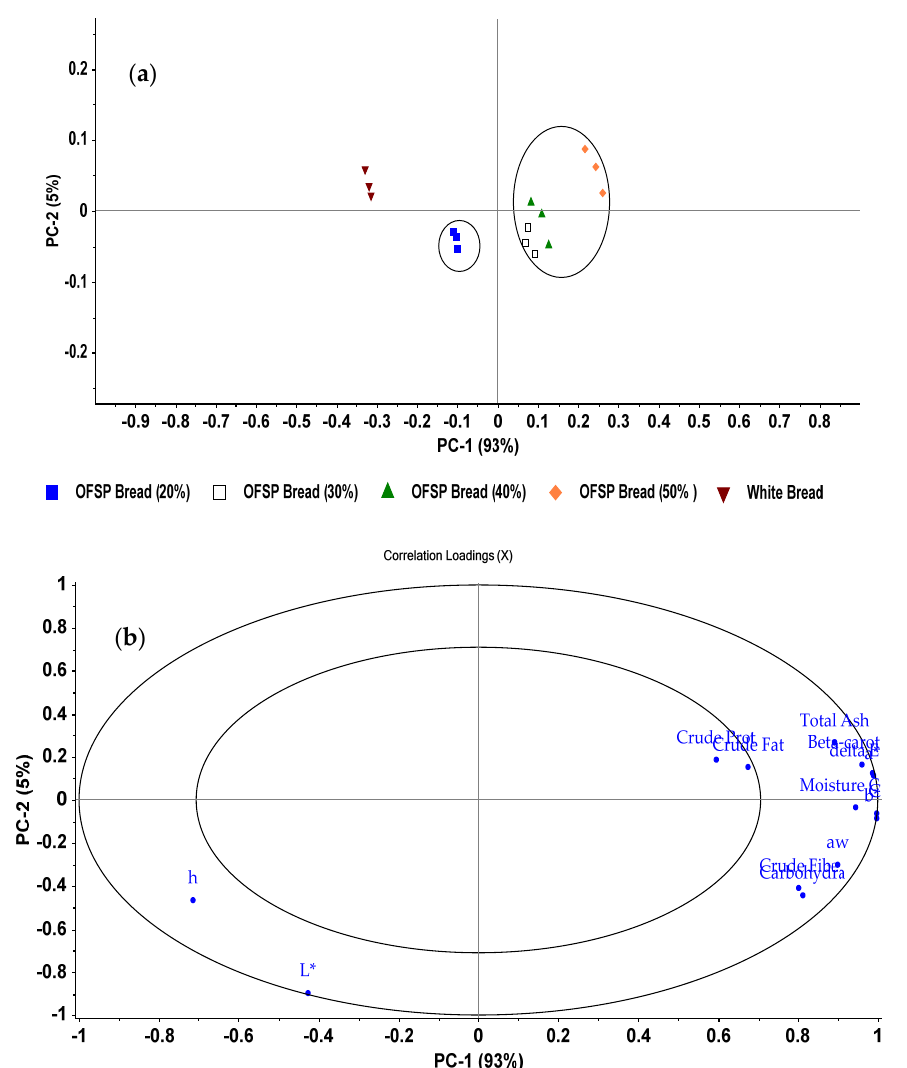
Figure 4. ( a ) Score plots, and ( b ) correlation loading plots from the principal component analysis of wheat − OFSP purée bread quality a tt ributes.